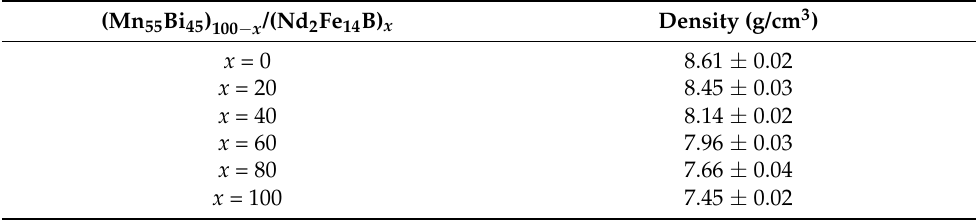
Table 1. The density values of the bulk (Mn 55 Bi 45 ) 100 − x /(Nd 2 Fe 14 B) x hybrid magnetic alloys.